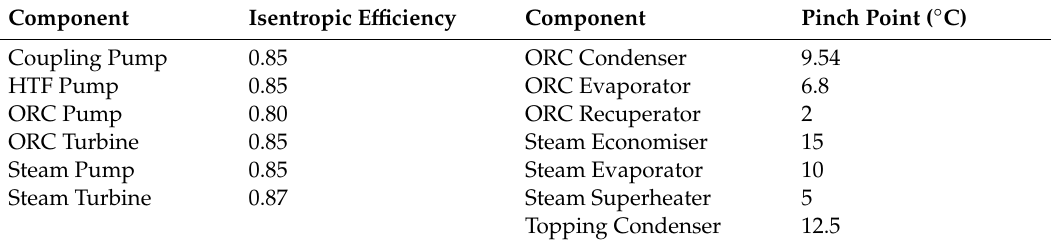
Table 4. The input values of the main parameters in the advanced exergy analysis.